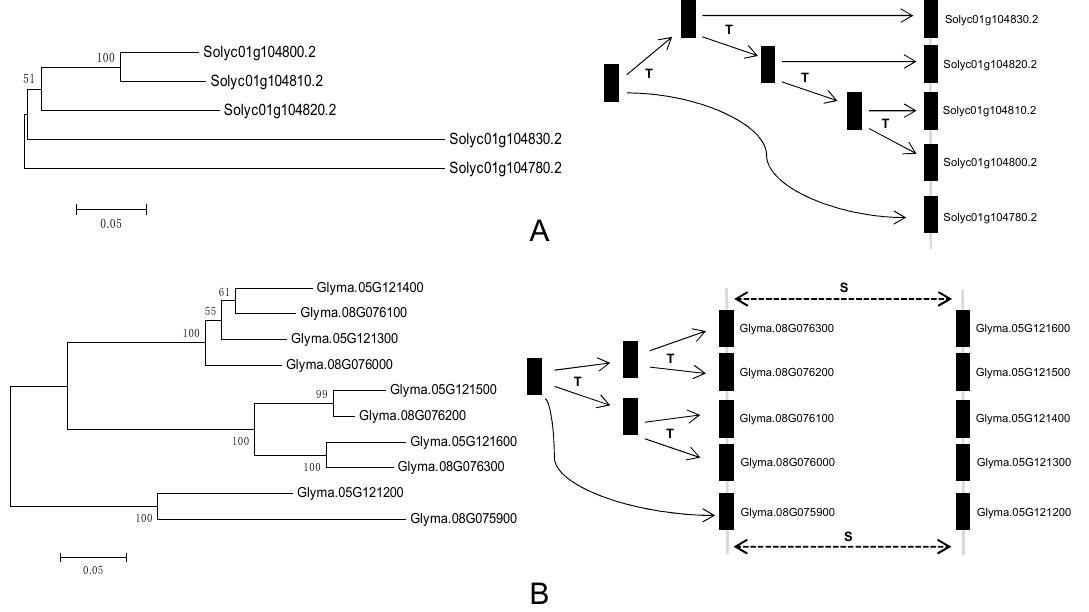
Figure 2. Origins of some tomato and soybean VIT genes by tandem and segmental duplication. The letters T and S indicate the positions where tandem and segmental duplication have occurred, respectively. Table 2. Divergence time of the VIT paralogues in tomato and